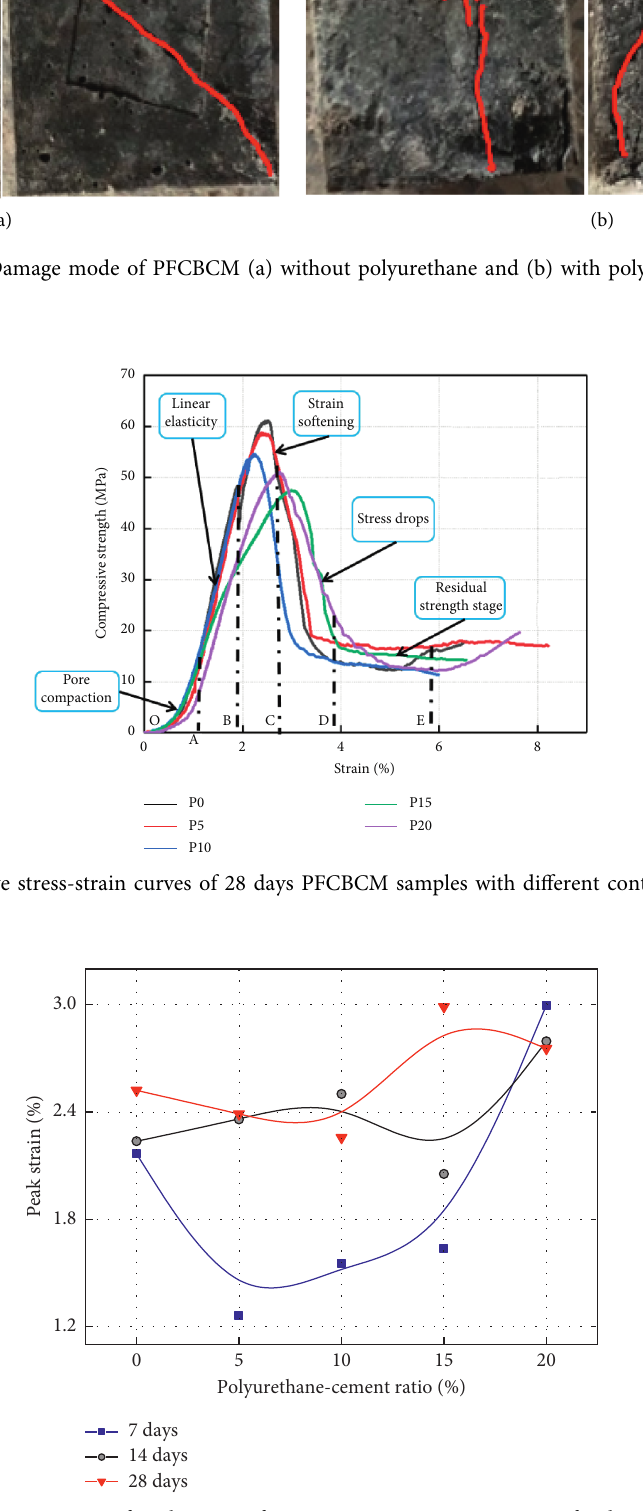
Figure 5: Variations of peak strain of PFCBCM versus mass content of